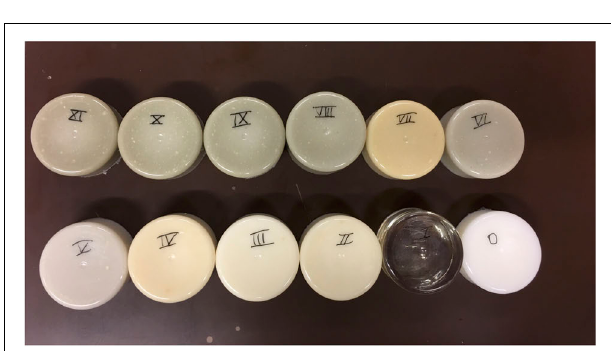
FIGURE 1 | Two-dimensional image of the hollow thorax phantom. The images display the hollow skeletal integument (pink) consisting of ribs, sternum and vertebrae, embedded in a transparent body (blue). (A) Ventral segment, (B) Dorsal segment.